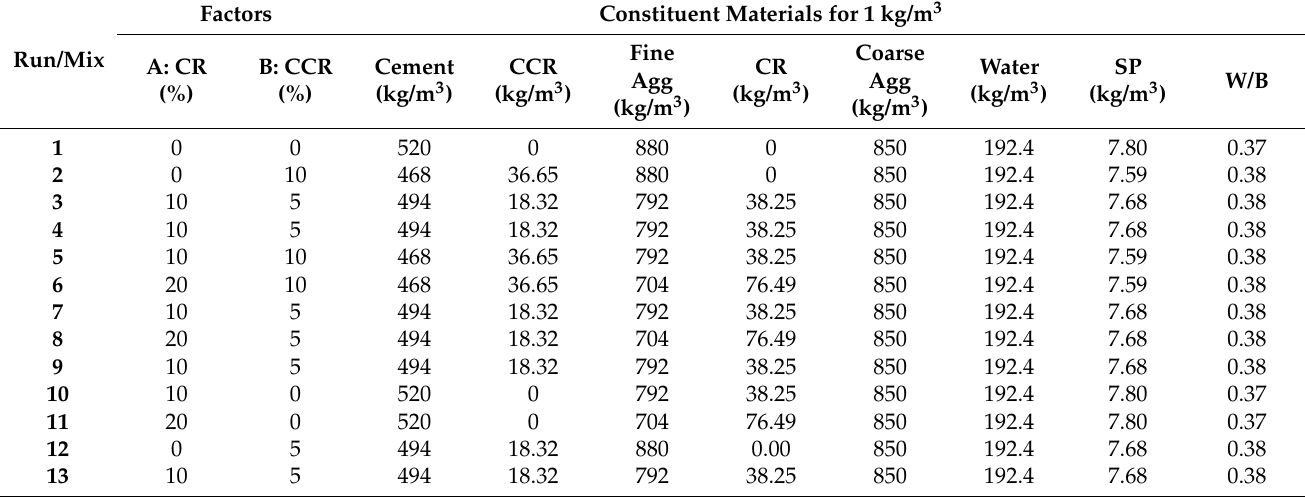
Table 2. Experimental design mix and constituent